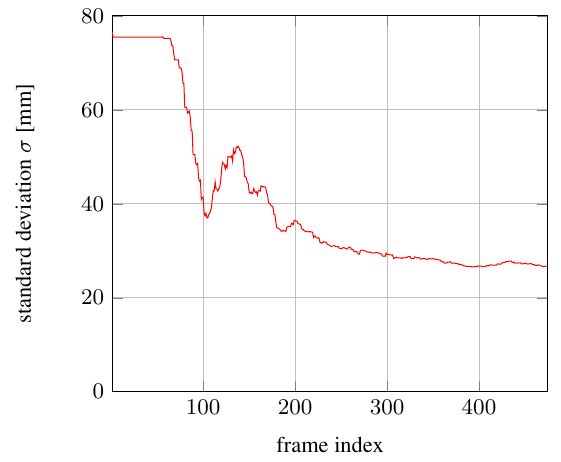
Figure 9. Standard deviation of measured depth for a chessboard target in 3 . 79 m distance to the camera. Tracking errors resulted in an not constantly descending standard